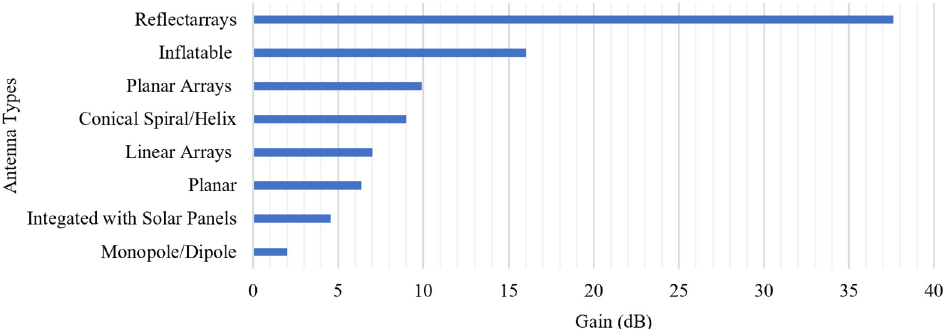
Figure 9. Gain of single-element antennas and antenna arrays used in CubeSats.